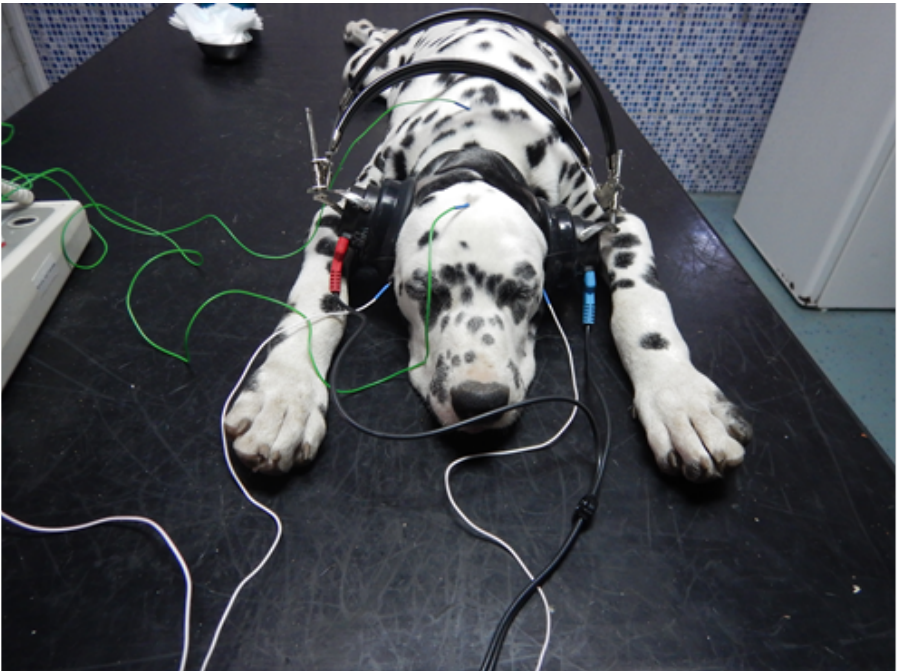
Fig. 1 Positioning of headphones in BAER test